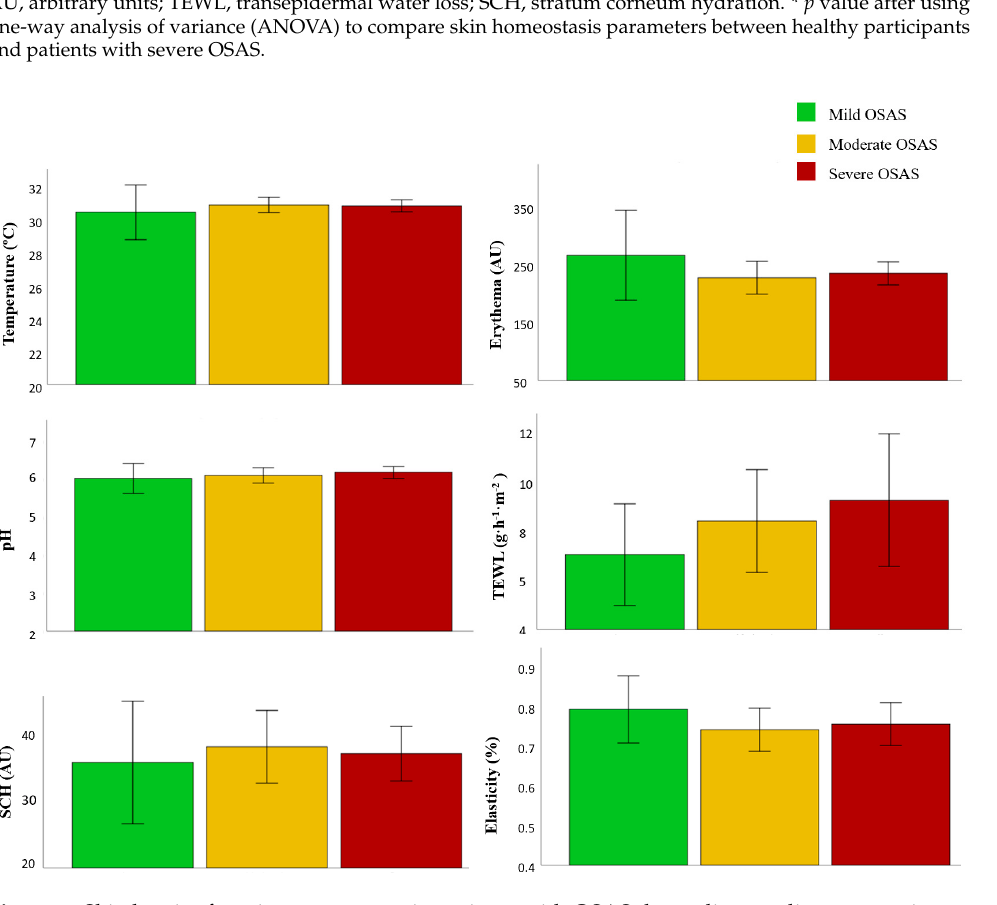
Figure 2. Skin barrier function parameters in patients with OSAS depending on disease severity. 3.3. The Impact of Exposome Factors on Skin Homeostasis Patients with OSAS showed worse results in most of the questionnaires evaluated, as seen in Table 4. OSAS patients had significantly lower sleep quality (11.89 vs. 6.47 PSQI score; p < 0.001) and lower adherence to the Mediterranean Diet (8.46 vs. 9.77; p = 0.005) than healthy individuals. Moreover, OSAS patients had significantly higher levels of anx- iety (9.27 vs. 6.47 HADS-A score; p = 0.008) and depression (7.07 vs. 3.83; p = 0.001 HADS- D score) than healthy individuals. Perceived stress was also almost significantly higher in patients with OSAS (25.29 vs. 20.7 PSS score; p = 0.058). The impact of exposome factors on TEWL was also evaluated, as seen in Table 5. Concerning sleep quality according to PSQI, 60% (18/30) of healthy individuals and 96.4% (52/56) of patients with OSAS were classified as poor sleepers (scores ≥ 5 in PSQI). Healthy individuals that were also good sleepers showed higher TEWL values than bad sleepers (8.25 vs. 7.63, p = 0.3). No differences in OSAS patients were found. There were 40% (12/30) healthy individuals and 60.7% (34/56) patients with OSAS that reported high levels of anxiety (scores ≥ 8 in HADS-A). Healthy individuals with high anxiety levels showed higher TEWL values than those with low anxiety (8.26 vs. 7.86 g·m − 2 ·h − 1 , p = 0.558). TEWL absolute values were also higher in patients with OSAS and higher anxiety levels than in those with low anxiety. Regarding depression, 10% (3/30) healthy individuals and 37.5% (21/56) of patients with OSAS reported high levels of de- pression (scores ≥ 8 in HADS-D). Healthy participants with higher depression values showed higher TEWL values (9.30 vs. 8.08 g·m − 2 ·h − 1 ; p = 0.228) than those with low